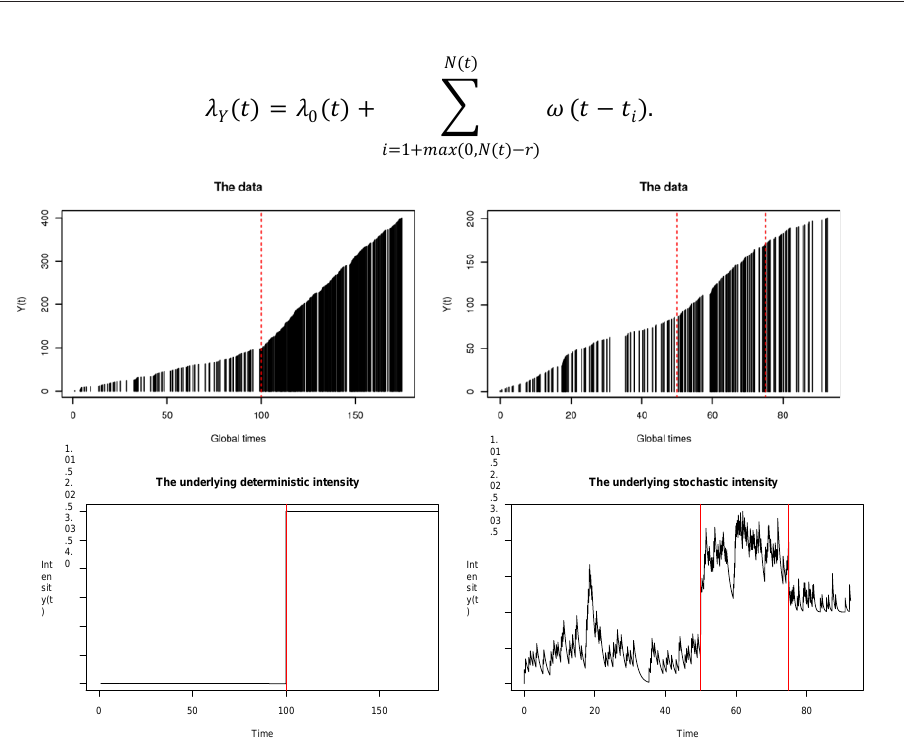
Fig. 1. Data reaction to changes under deterministic (left panel) and random (right panel)